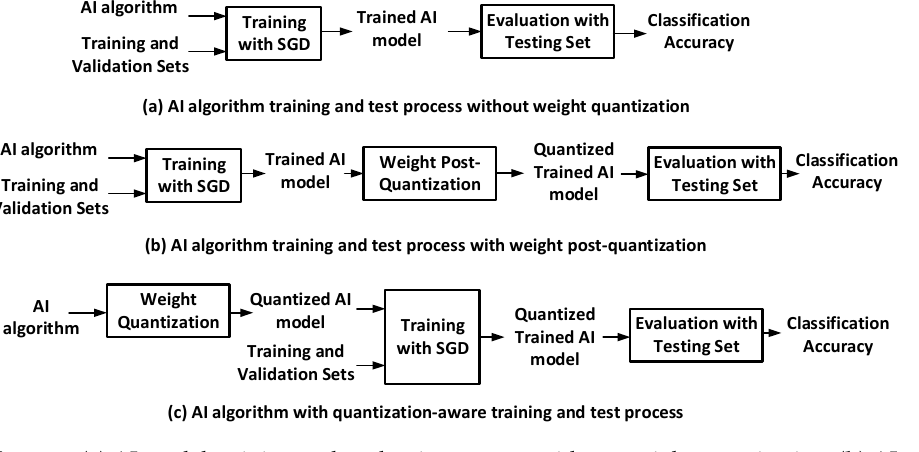
Figure 5. ( a ) AI model training and evaluation process without weight quantization, ( b ) AI model training and evaluation process with post-training weight quantization, and ( c ) quantization-aware AI model training and